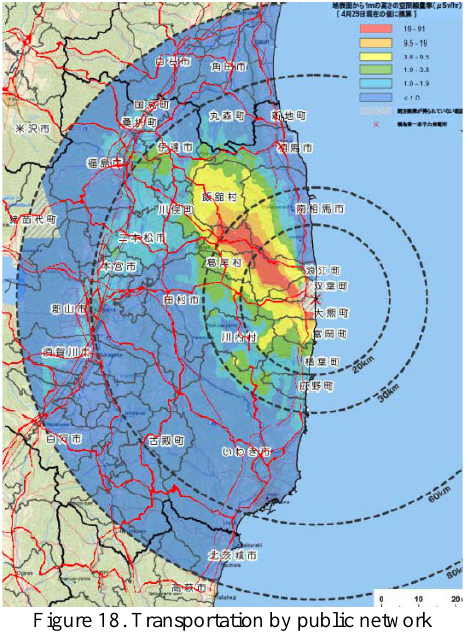
Fi gure 18. Transportation by public network From these elements, emission by explosions and leaks, advective diffusion in the atmosphere, and movement on the ground surface should be analysed as the comprehensive pollution mechanism near